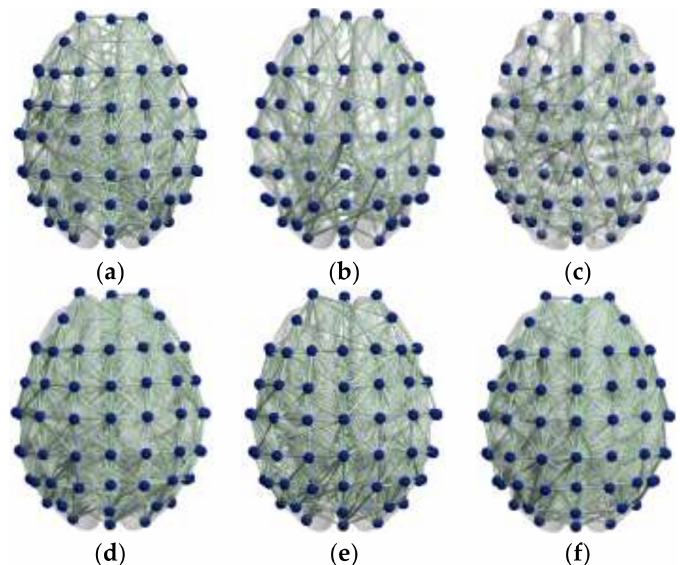
Figure 3. ( a ) Resting state before motor imagery task in the mu rhythm. ( b ) State during motor imagery task in the mu rhythm. ( c ) Resting state after motor imagery task in the mu rhythm. ( d ) Resting state before motor imagery task in the beta rhythm. ( e ) State during motor imagery task in the beta rhythm. ( f ) Resting state after motor imagery task in the beta